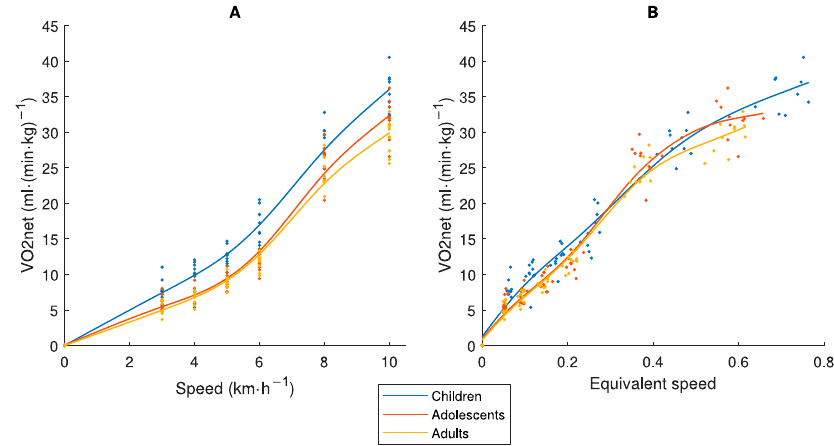
Figure 2. Relationship between ( A ) Speed abs or ( B ) equivalent speed (Speed eq ) and net oxygen consumption (VO 2net ), in children 9–11, adolescents 14–16 and adults 23–44 years old.